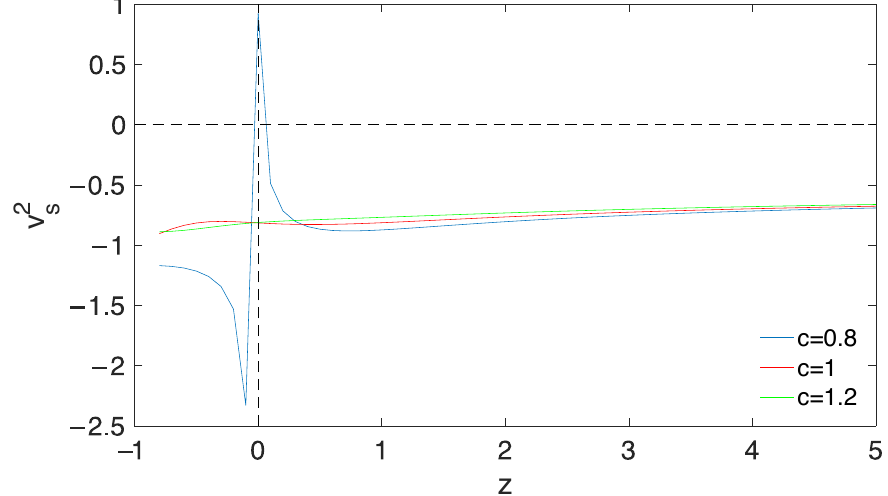
Figure 5. Square speed sound parameter v 2 s versus redshift z